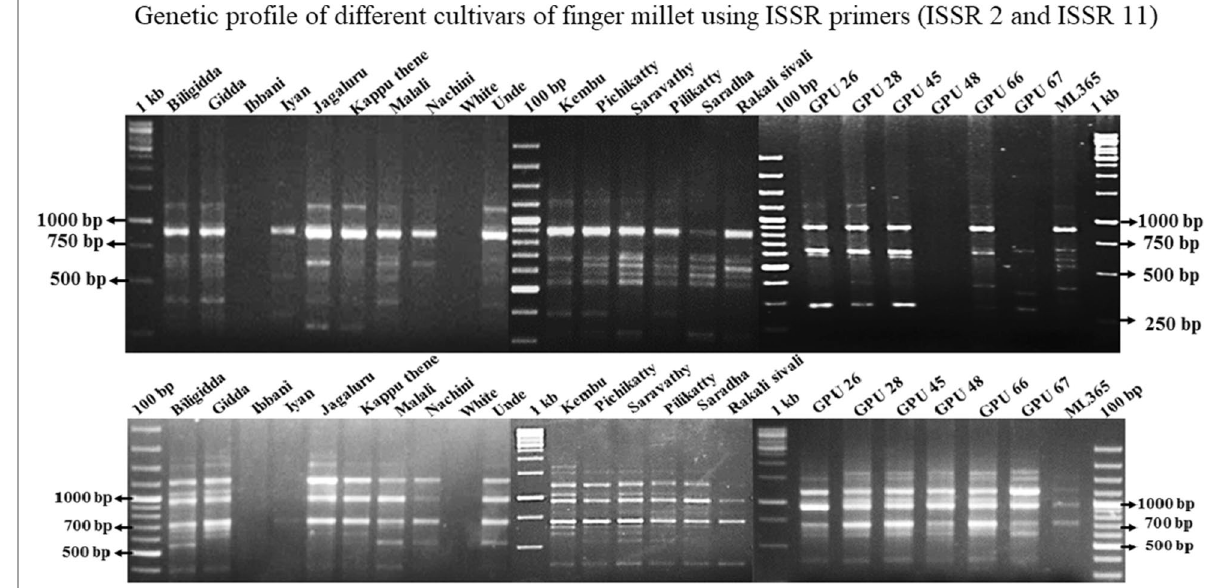
Fig. 1 Genetic profile of different cultivars of finger millet using ISSR primers (ISSR 2 and ISSR